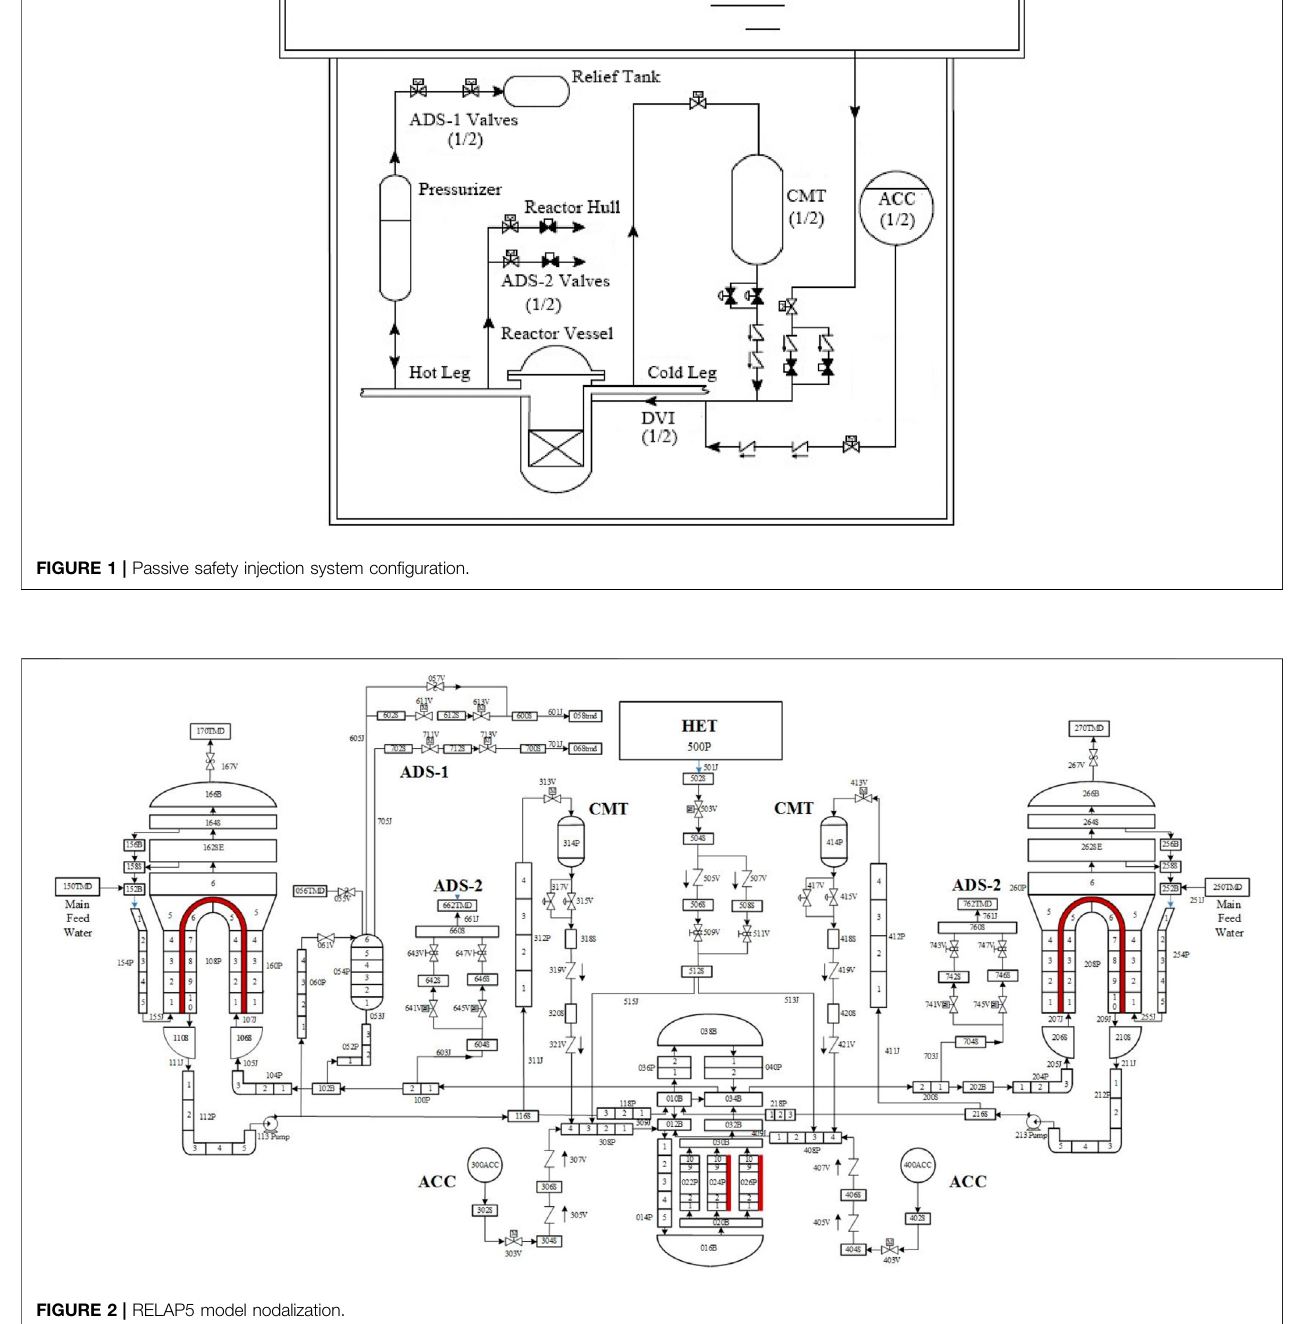
FIGURE 2 | RELAP5 model nodalization.